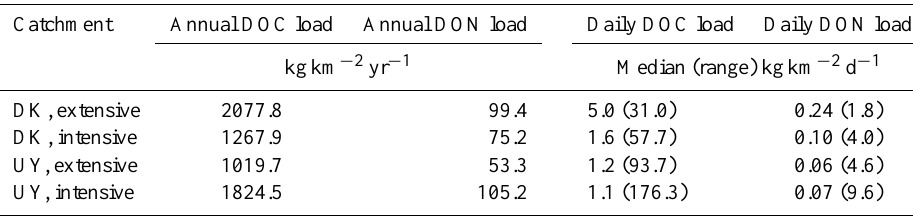
Table 2. Loads of DOC and DON for the sampled catchments in 2011 and the median (range) daily loads for the whole sampling period. DK: Denmark, UY: Uruguay, extensive: extensive farming, intensive: intensive farming.